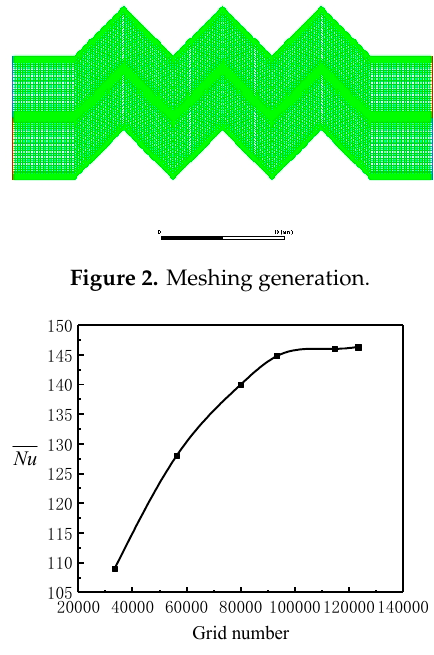
Figure 3. Grid independence verification.